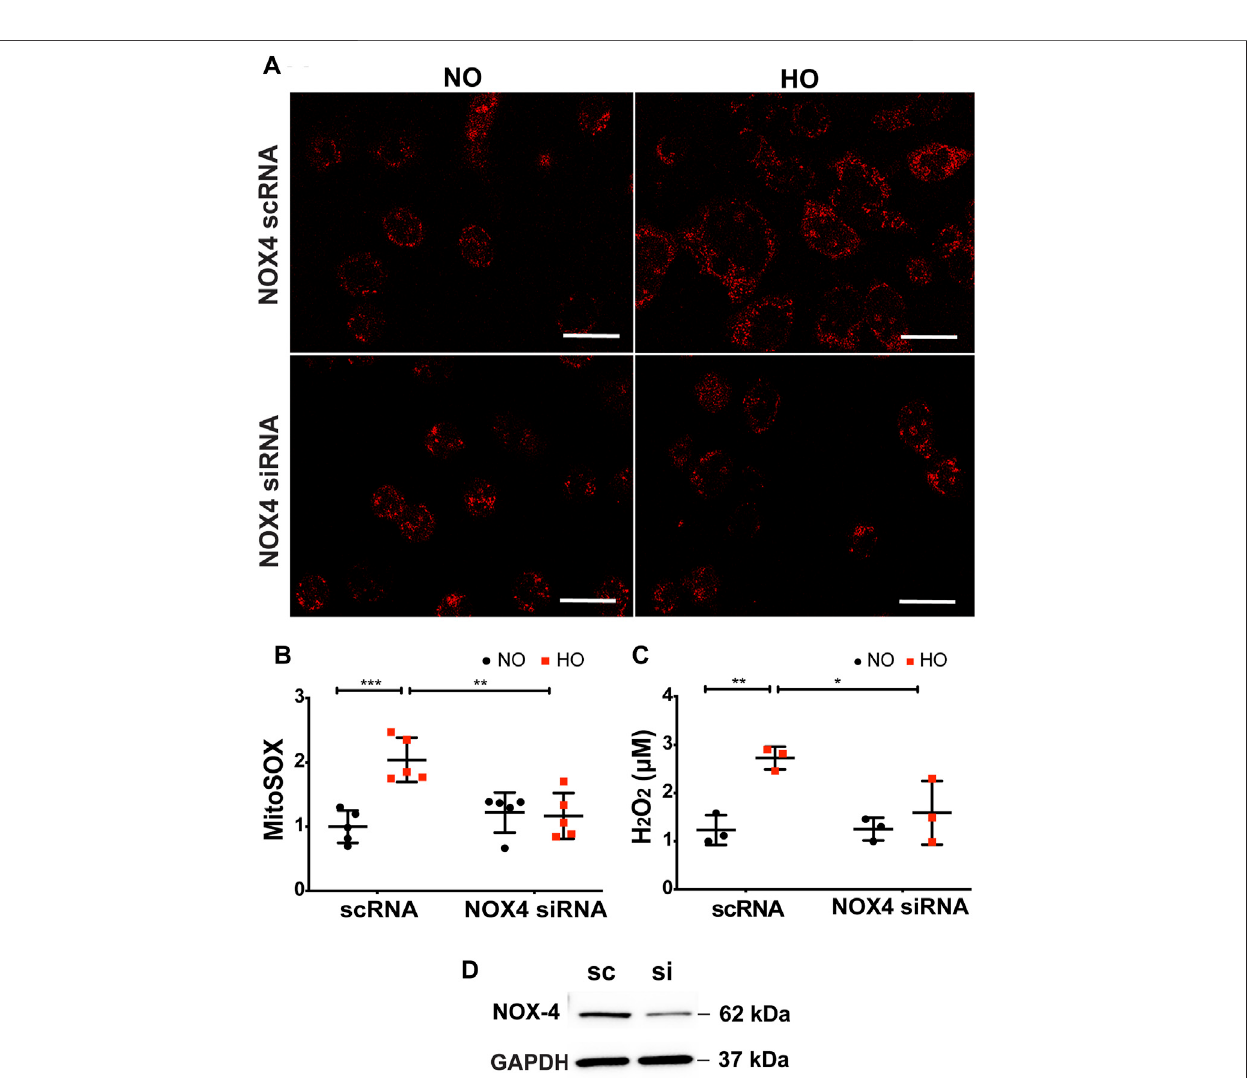
Frontiers in Pharmacology |